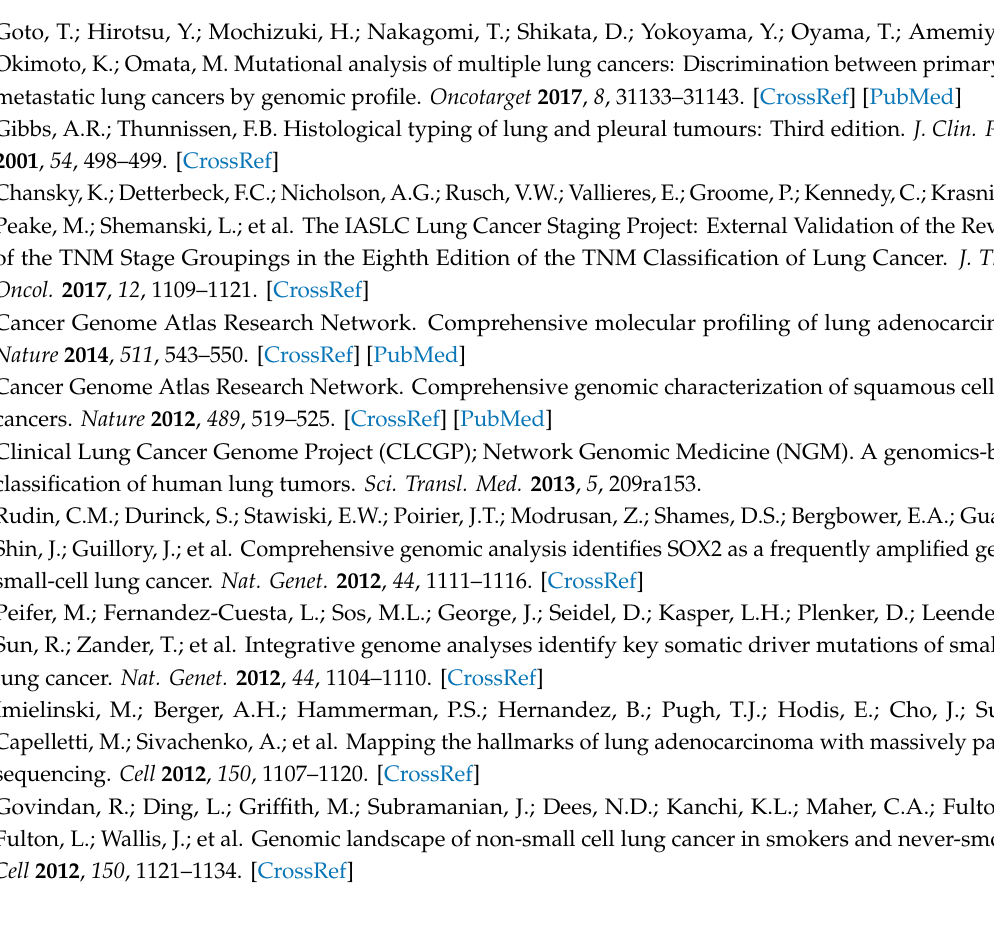
Table S1: The genes targeted in the cancer panel, Table S2: Patient characteristics, Table S3: Mutation data in each cancer